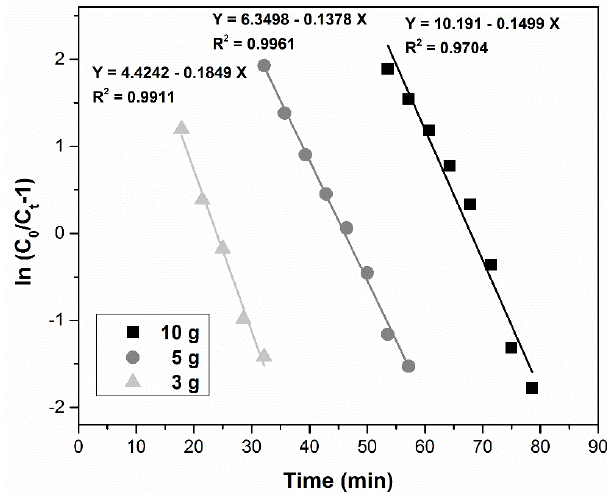
Figure10. ThomasmodelfortheadsorptionofPd(II)inafixed-bedcolumnatvariousMgSiO 3 -cysamounts. Figure 10. Thomas model for the adsorption of Pd(II) in a fixed-bed column at various MgSiO3-cys amounts. Table 2. Pd(II) adsorption process parameters in a fixed-bed Table 2. Pd(II) adsorption process parameters in a fixed-bed column.